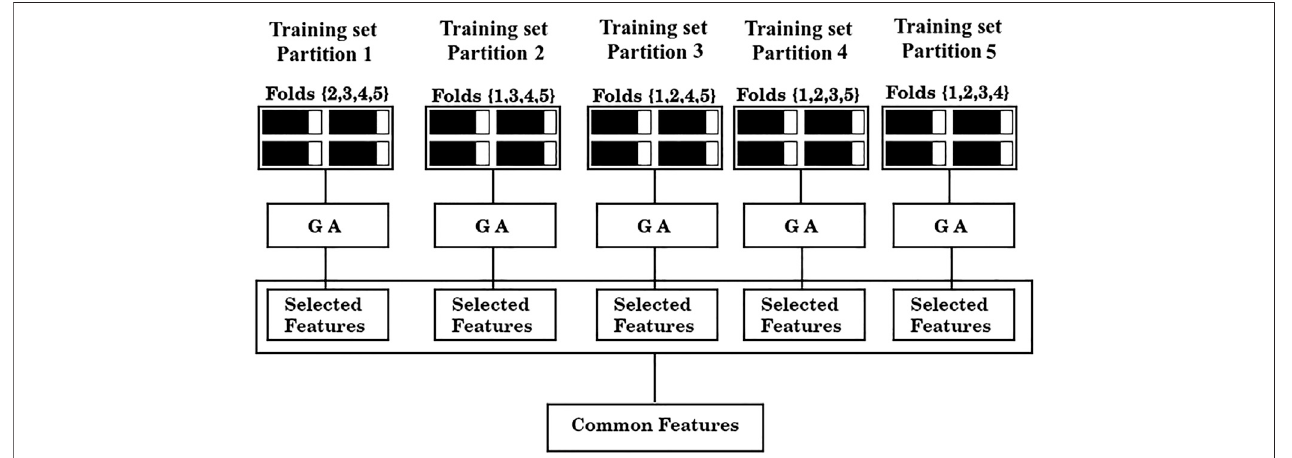
FIGURE 2 | Feature selection scheme. From left to right, training data from partitions 1-5 are fed to a GA. The GA yields a solution for each partition ( “ Selected features ” ) and fi nally, the shared features between those solutions are collected ( “ Common features ” ).